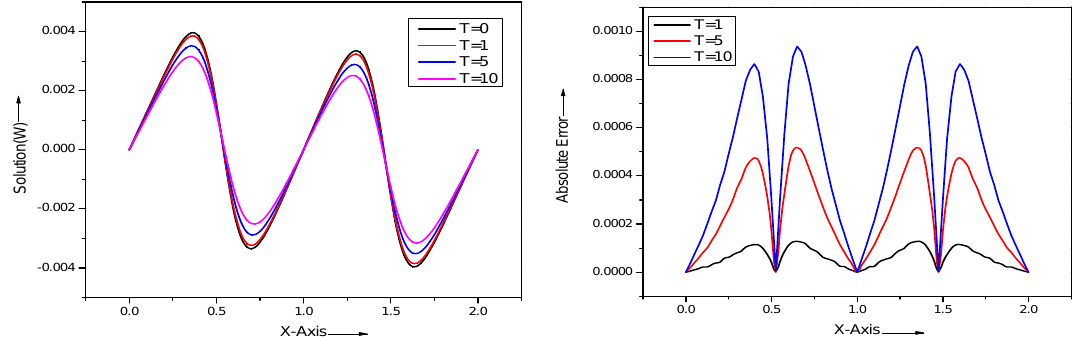
Figure 12. Numerical approximation ( left ) and absolute errors ( right ) of problem 5.4 for ∆ x = 0.025, ν d = 0.001, τ = 0.01 at different times T